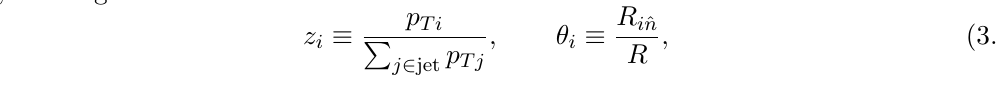
. (cid:12) [0 ; 1] is a momentum fraction, and (cid:18) i [0 ; 1] 2 2 0 and (cid:12) 0 determine (cid:21) (cid:21)